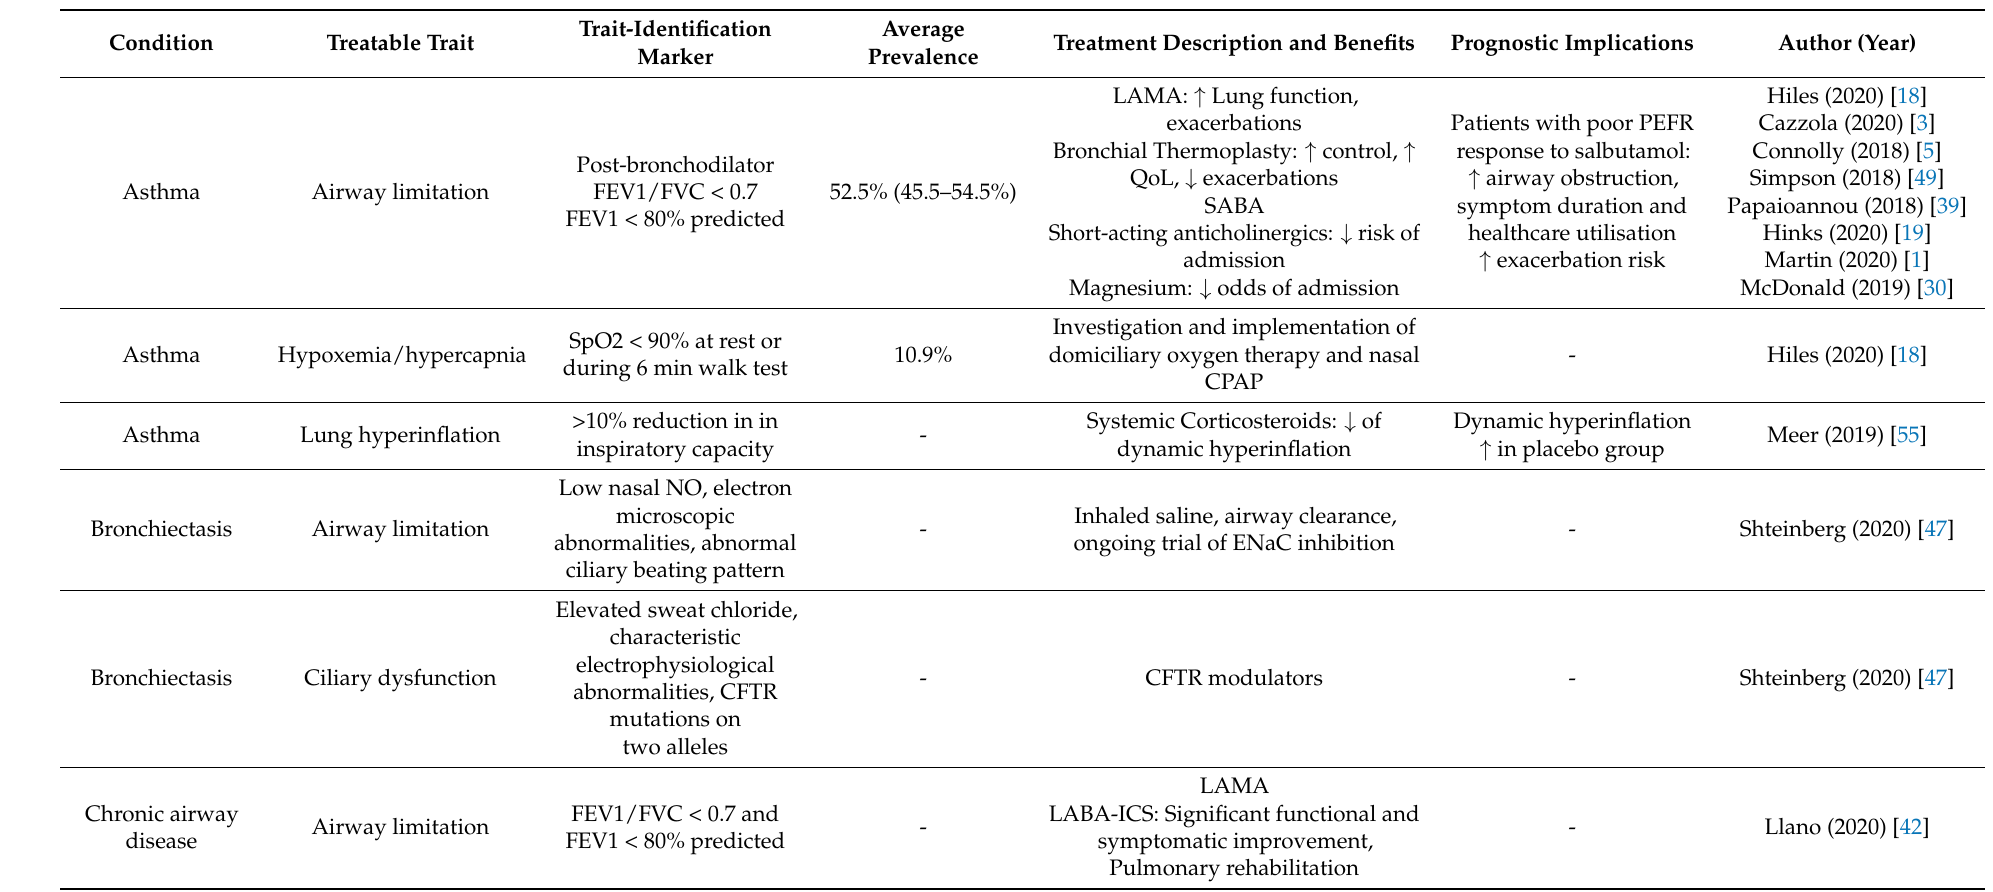
Table 2. Overview of physiological treatable